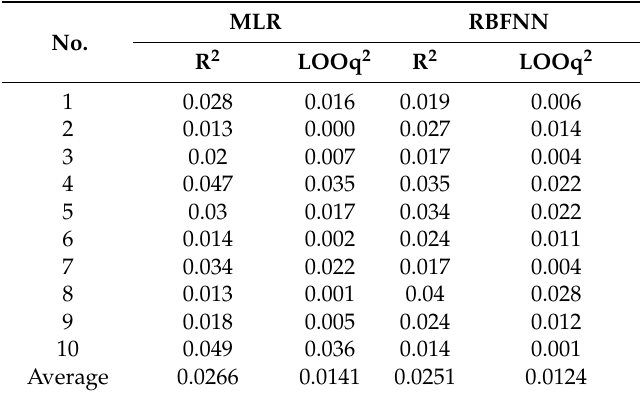
Table 6. The R 2 and LOOq 2 values of 10 Y-randomization tests.